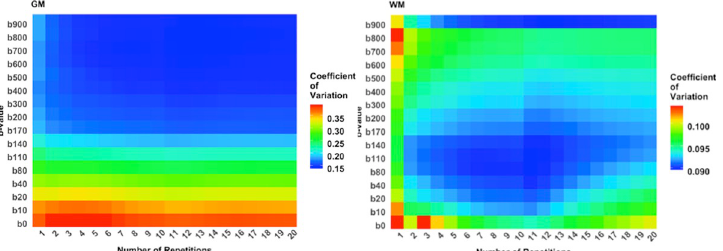
Fig 2. Coefficient of variation (SD/mean) as a function of b values and number of averages, in the gray matter (left) and the white matter (right) for four healthy volunteers in DWI trace images in b-values ranging from 0 to 900 s/mm 2 and number of repetitions for signal averaging in 1 to 20. Gray matter variation begins to drop after b = 170 s/mm 2 and with 4 repetitions, while white matter variation is generally less and with negligible differences between b-values and repetitions in range 9% to 10.5%, and lowest points around b = 80–140 s/mm 2 and when using 4 to 13 averages.